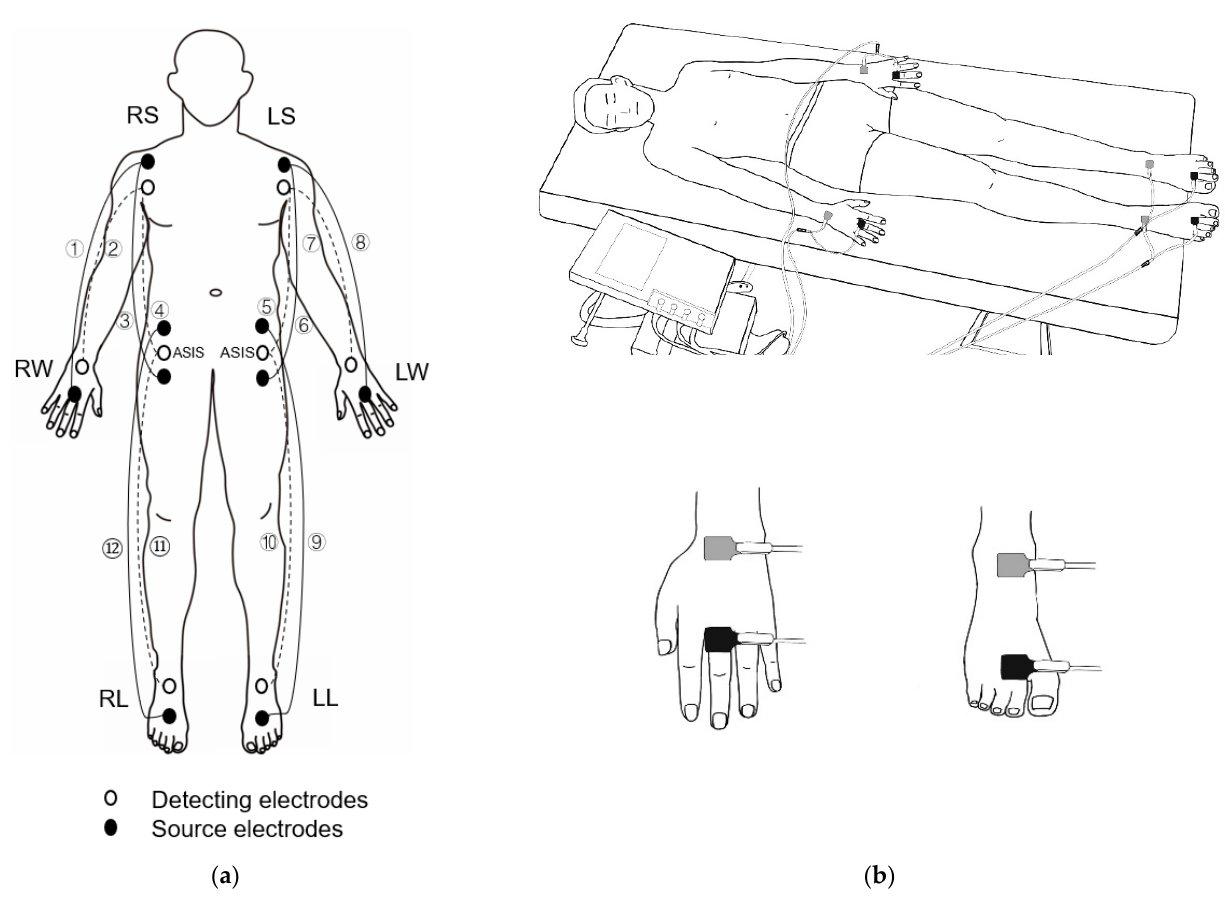
Figure 1. The posture for assessment and locations of the electrodes. ( a ) The direct tetrapolar seg- mental BIA and ( b ) octapolar segmental BIA. ( ① a pair of source electrodes on the right arm, ② a pair of detecting electrodes on the right arm, ③ a pair of source electrodes on the right trunk, ④ a pair of detecting electrodes on the right trunk, ⑤ a pair of detecting electrodes on the left trunk, ⑥ a pair of source electrodes on the left trunk, ⑦ a pair of detecting electrodes of the left arm ⑧ a pair of source electrodes of the left arm, ⑨ a pair of source electrodes on the left lower limb, ⑩ a pair of detecting electrodes of the left lower limb, ⑪ a pair of detecting electrodes on the right limb, and ⑫ a pair of source electrodes of the right limb. The trunk impedance value with the TS-BIA is mean to left and right.)